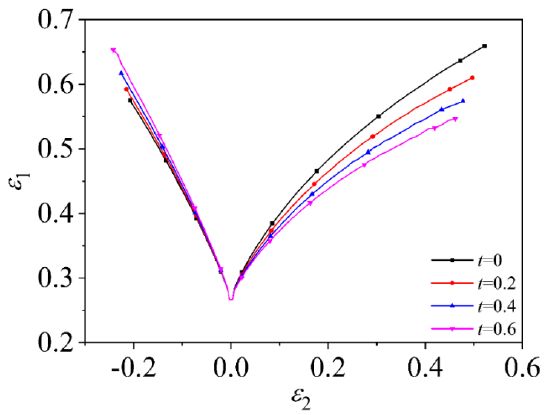
Figure 11. FLD of material TRIP780 based on Hill48 yield criterion and C-H instability criterion.